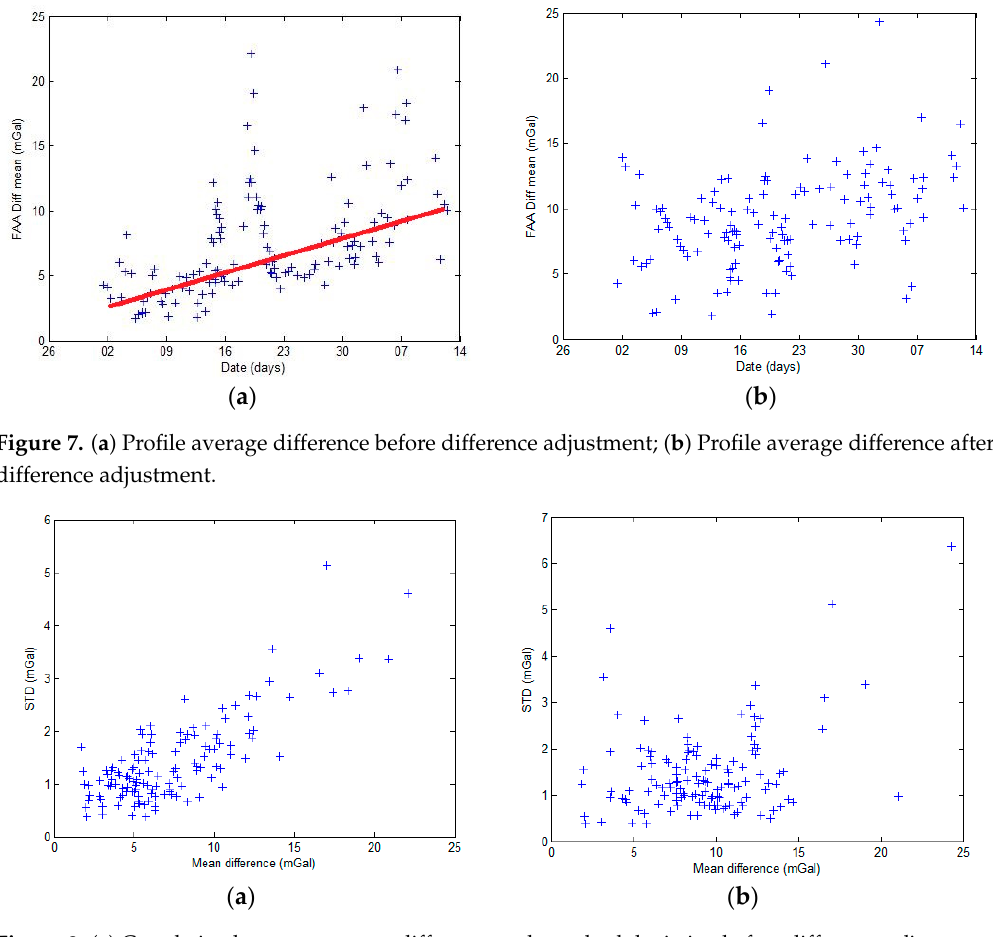
Figure 8. ( a ) Correlation between average difference and standard deviation before difference adjustment; ( b ) Correlation between average difference and standard deviation after difference adjustment. Comparison analysis of the raw data shows that this semi-systematic error is caused by difference adjustment.